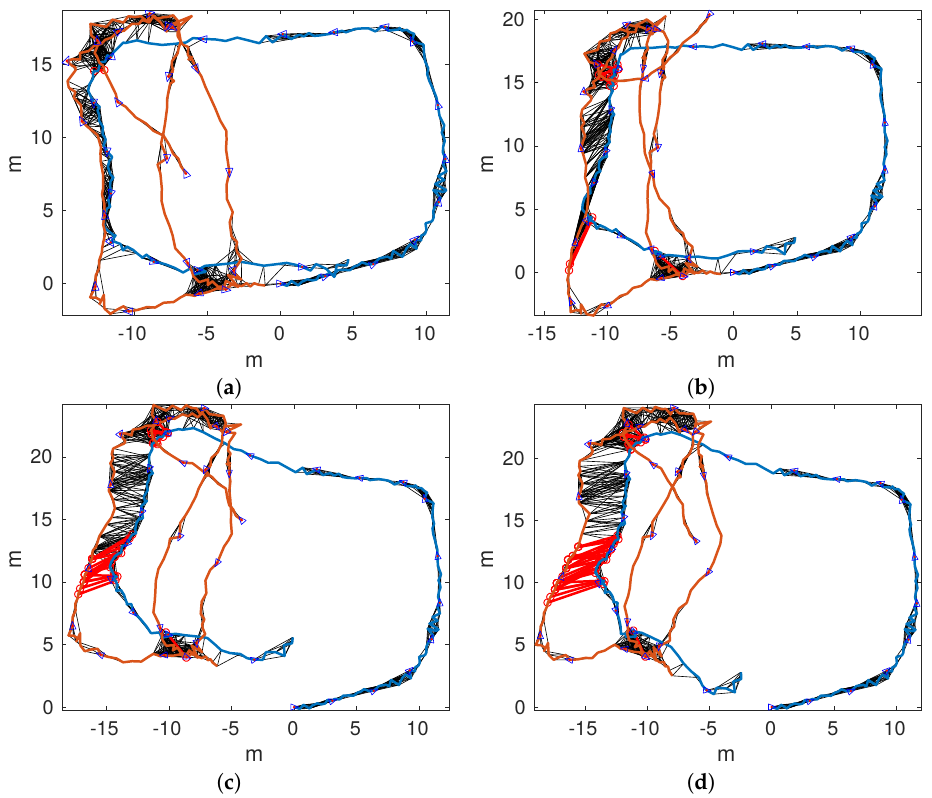
Figure 19. Obtained trajectories for V 5 and V 6: ( a ) MSLAM1, ( b ) MSLAM10, ( c ) MSLAM20, and ( d ) MSLAM30. In SLAM, thick lines are the trajectories, thin lines are the detected loops, and the triangles show the estimated AUV orientation.